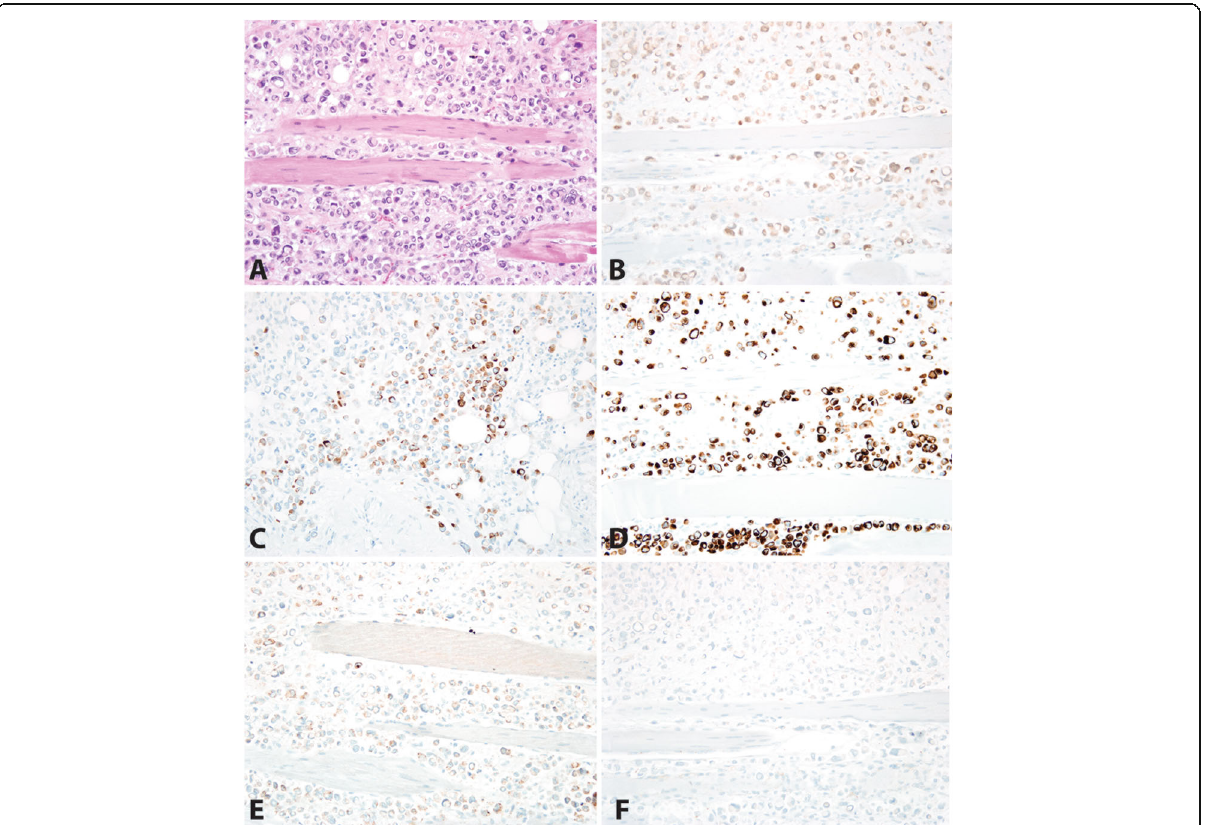
Fig. 3 Immunohistochemical Profile of Plasmacytoid Urothelial Carcinoma in the Right Abdominal Wall. Hematoxylin and Eosin demonstrates carcinoma in sheets splaying the skeletal muscle ( a ). The neoplastic cells are diffusely positive for GATA-3 ( b ), CK20 ( c ), and CK7 ( d ). A subset of neoplastic cells is positive for CD 138 ( e ). E-cadherin is negative ( f ). Additional immunohistochemical stains show the tumor cells are diffusely positive for pancytokeratin, patchy expression of CK903, and p53, and focal expression of PAX-8 and negative for CDX-2, p63, NKX3.1, PAX-2 and